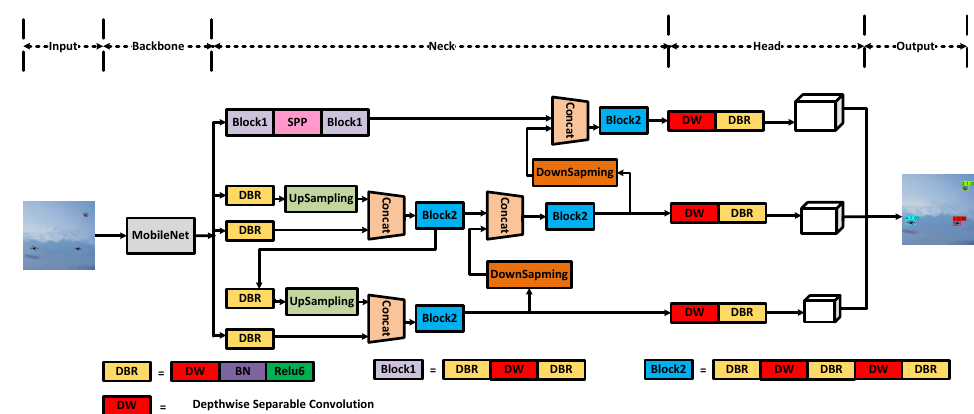
Figure 1. The structure of lightweight and accurate UAV detection method based on YOLOv4.